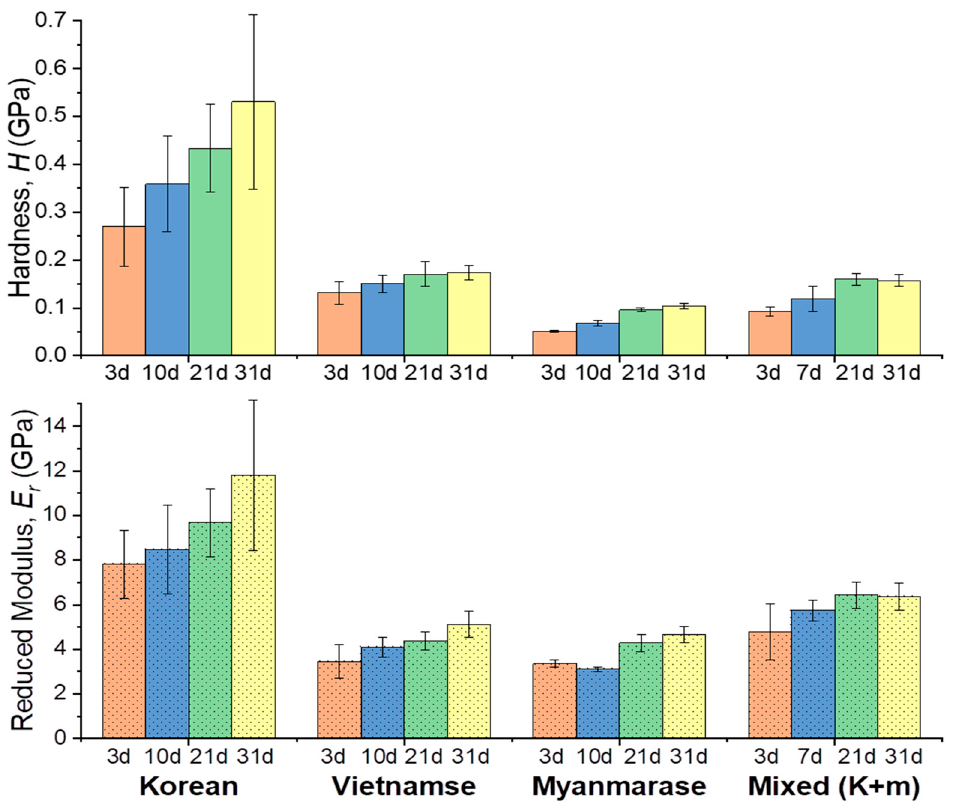
Figure 6. Calculated hardnesses H and reduced moduli E r of Oriental lacquers in force–displacement curves: Korean, Vietnamese, Myanmarese, Korean/Myanmarese mixture (1/1, w / w ).